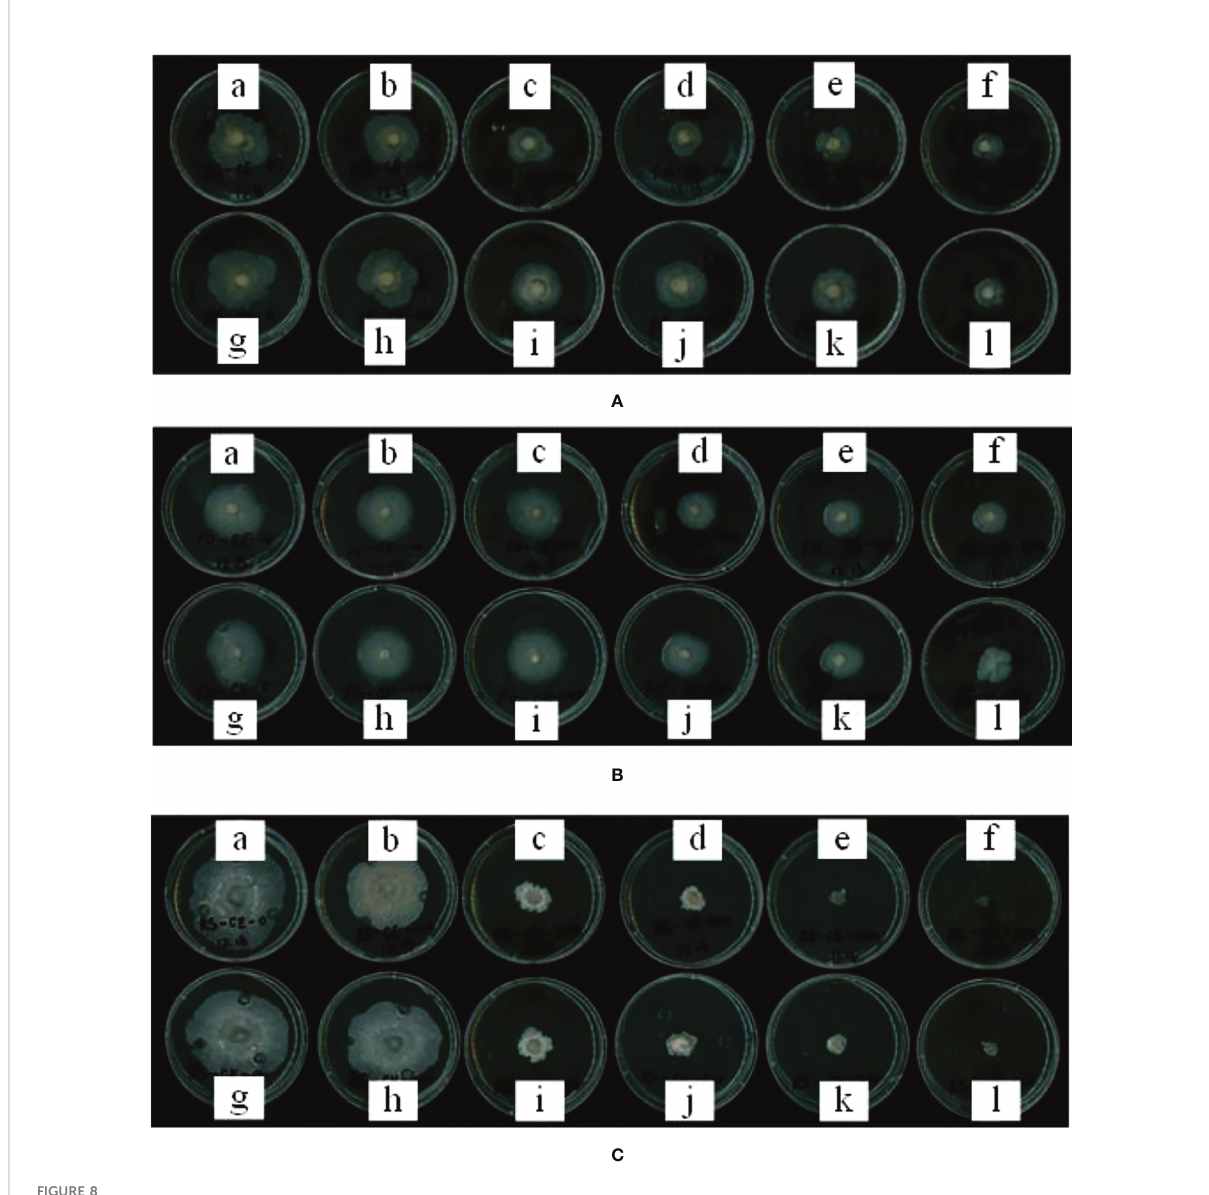
FIGURE 8 Effect of root exudates of CE and CK on mycelial growth of soil-borne diseases. (A – C) shows the effect of root exudates on the mycelial growth of Fusarium graminearum , Fusarium oxysporum and Rhizoctonia solani , respectively. (a – f) in each fi gure shows the mycelial growth of mycelium after adding CE root exudates with concentrations of 0, 1, 2, 3, 4, and 5 mg/ml for 5 days, and fi gures (g – l) shows the mycelial growth of mycelium after adding CK root exudates with concentrations of 0, 1, 2, 3, 4 and 5 mg/ml for 5 days; 0 mg/ml is the blank control